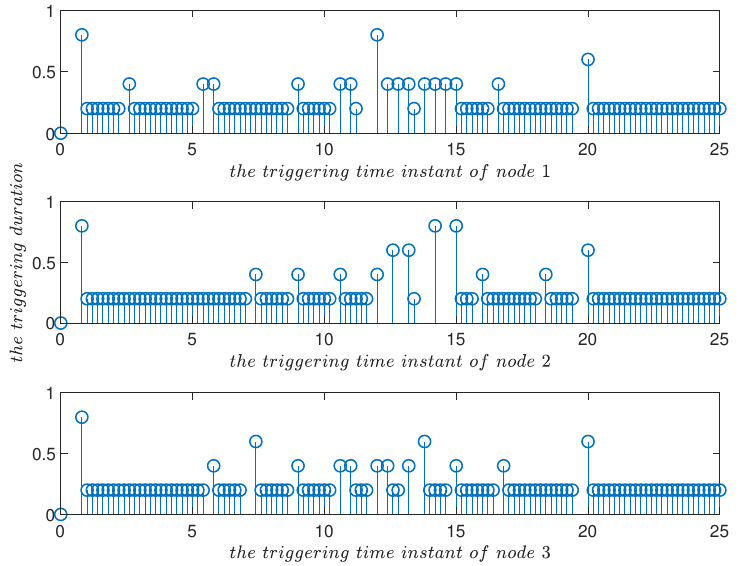
Figure 8. Triggering time instants and their duration in the improved event-triggered scheme in Example 1. In combination with Figure 7, triggering frequencies were different in multiple time periods [0, 5), [5, 10], [10, 15), [15, 20) and [20, 25).